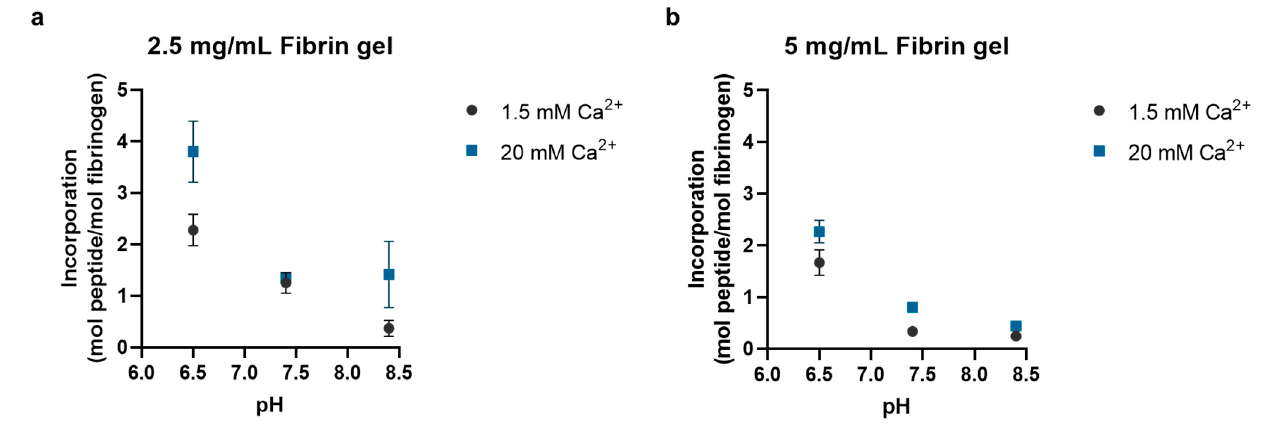
Figure 2. The pH-dependent enzymatic incorporation efficiency of the alpha 2-plasmin inhibitor peptide into fibrin hydrogels prepared with ( a ) 2.5 mg/mL fibrinogen and ( b ) 5 mg/mL fibrinogen. Increasing the pH of the fibrin polymerization reaction decreased the peptide incorporation while increasing the Ca 2+ concentration in the reaction increased the peptide incorporation. For all condi- tions, the fibrin hydrogels were prepared with 2 IU/mL thrombin and incubated at 37 °C for 30 min to allow the fibrin hydrogels to polymerize (n = 3).